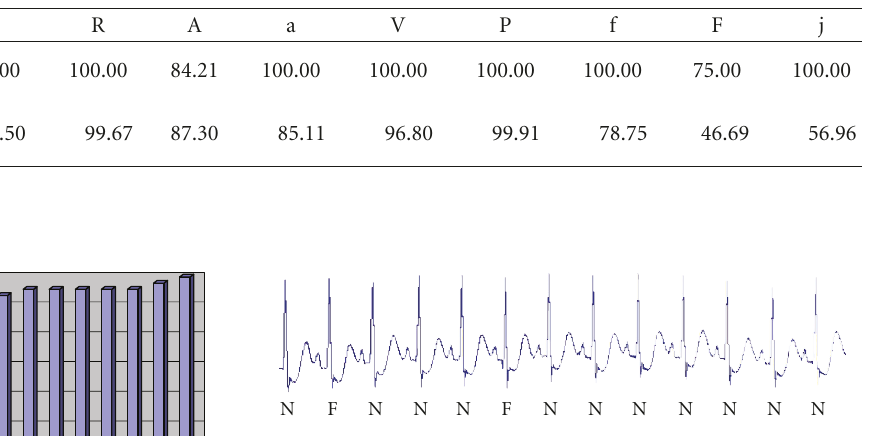
Figure 4: Raw tracing of ECG for patient 213 in the MIT-BIH database with fusion of ventricular and normal beats: a sequence of ECG is shown containing beats labeled as both normal (N) and fusion (F). The morphological di ff erences between the two classes of beats are subtle. This excerpt corresponds to time 4 : 15 in the recording.